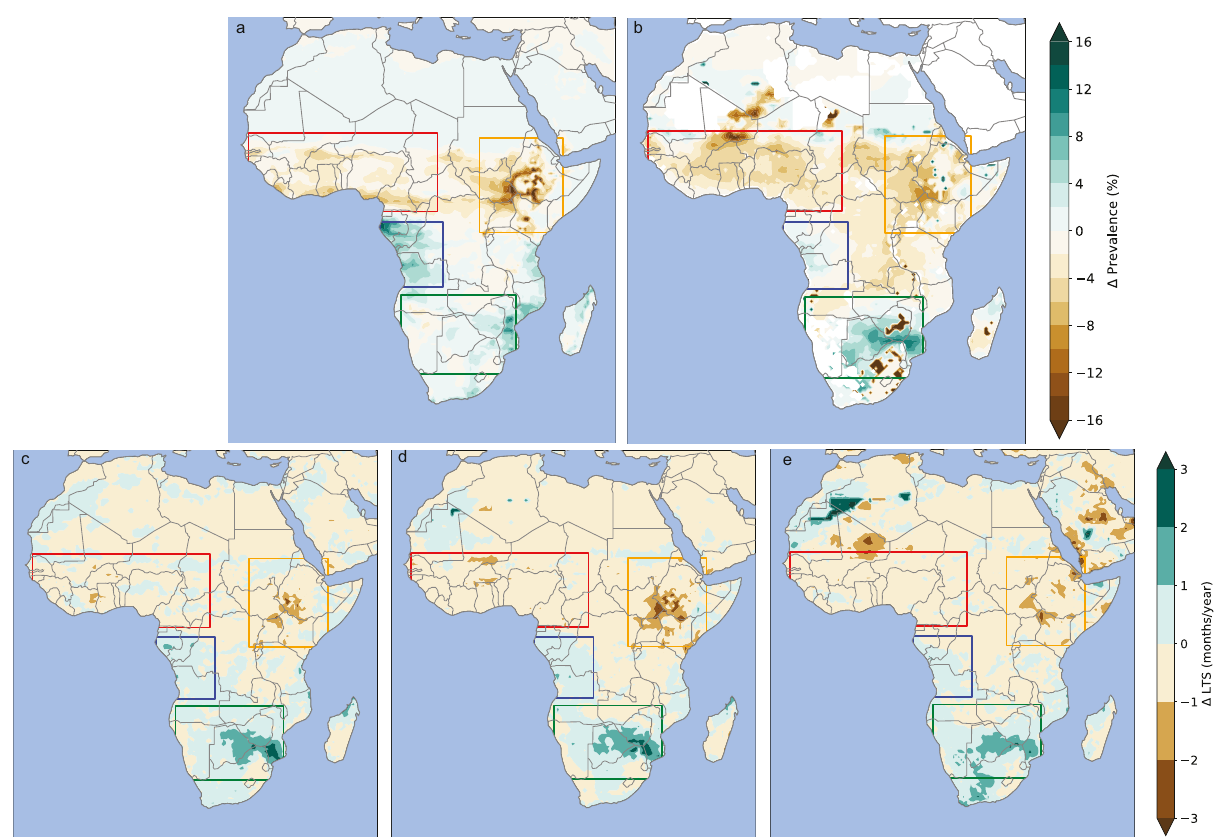
Fig. 5 Difference in malaria risk between the ICE1m simulation and the RCP8.5 simulation for the 2040s. Difference in prevalence (%) for ( a ) LMM and ( b ) VECTRI and difference in LTS (months) for ( c ) LMM_R 0 , ( d ) MARA, and ( e ) MIASMA. The different boxes represent key Africa regions (red for West Africa, orange for East Africa, blue for west central coasts of Africa, green for southern Africa), see “ Methods ” for further